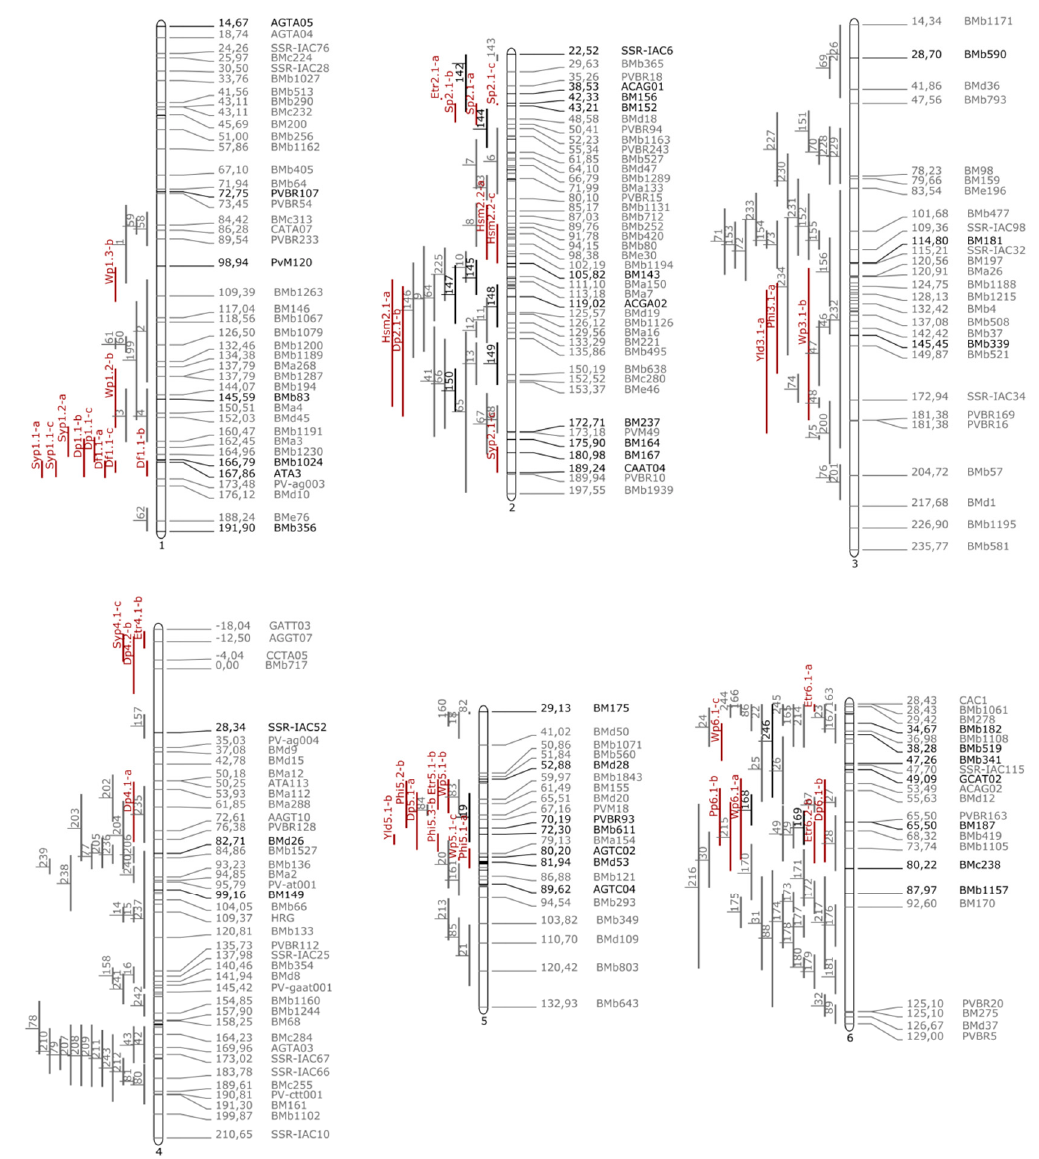
Figure 2. QTLs for physiology-associated traits, phenological traits, and yield-associated traits on the integrated genetic map of the ‘Tiber’ × ‘Starozagorski’ recombinant inbred line population and common bean consensus map reported by Galeano et al. [39]. Markers and QTLs from the novel ‘Tiber’ × ‘Starozagorski’ genetic map are marked bold and QTLs are colored red (for QTL names, see Table S1). The suffix in QTL names denotes whether they were detected in single environment analysis (-a, -b) or QTL × environment analysis (-c). For clarity reasons, not all loci names are displayed. QTLs from the consensus map are numbered (see Table S2) and colored gray for clarity reasons; only QTLs relevant for discussion are colored black.